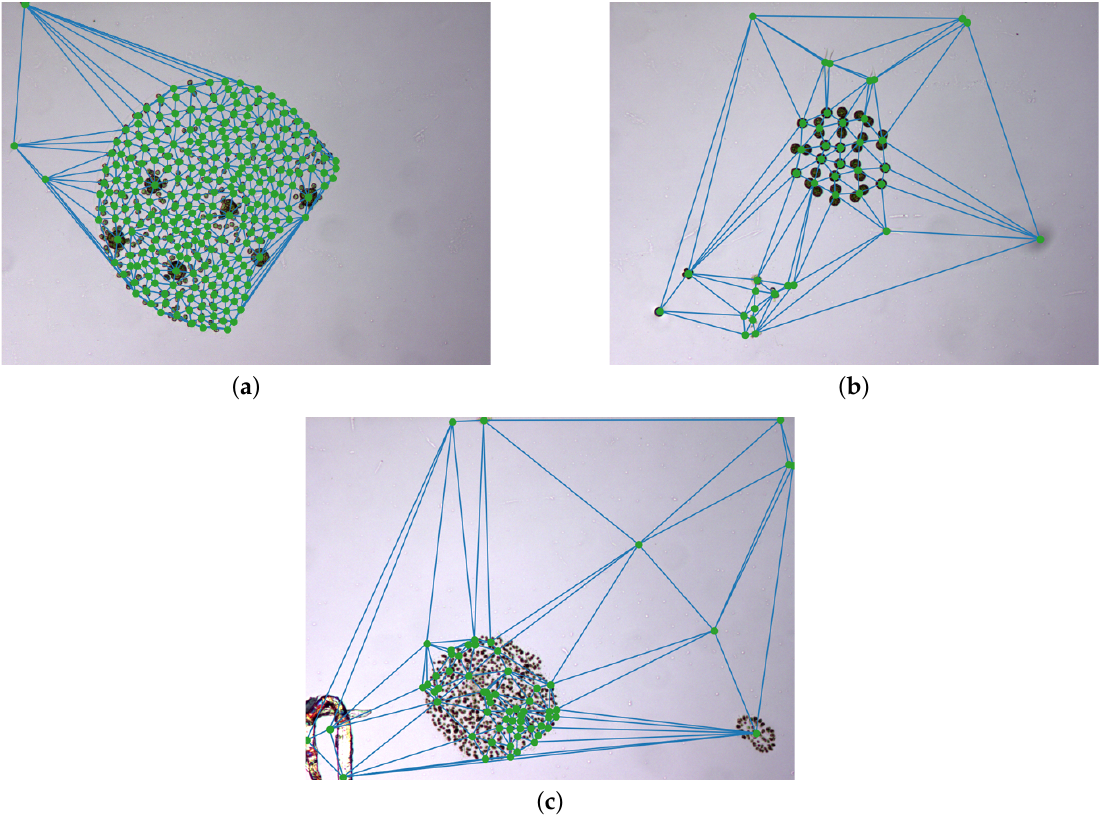
Figure 4. Examples of Delaunay triangulations over images containing different sparse species or colonies. ( a ) Volvox aureus . ( b ) Eudorina elegans . ( c ) Microcystis flos-aquae